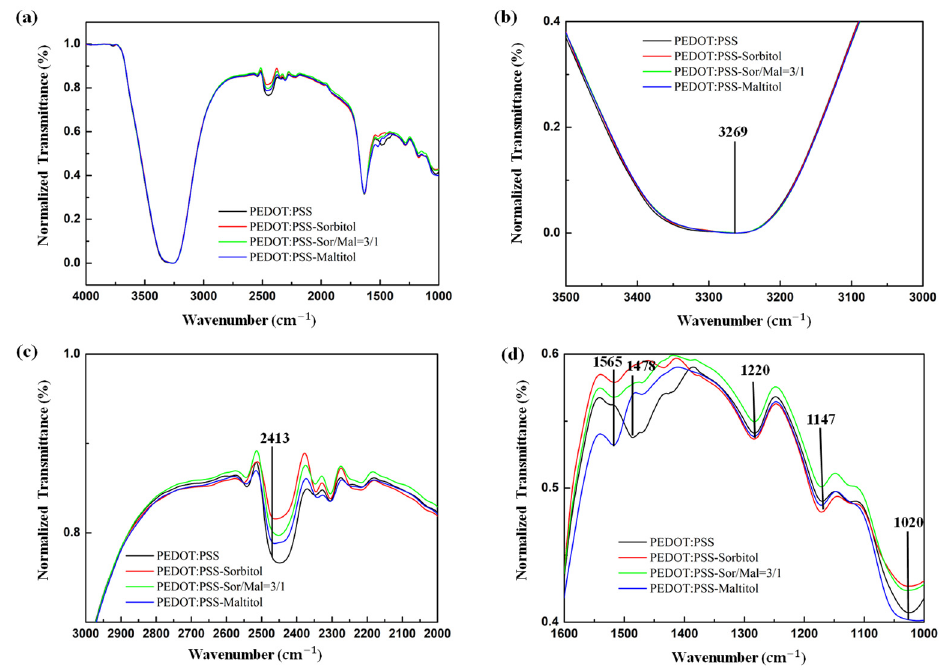
Figure 7. Normalized FTIR spectra of PEDOT: PSS without and with organic additives at ( a ) 4000~1000 cm − 1 , ( b ) 3500~3000 cm − 1 , ( c ) 3000~2000 cm − 1 , and ( d ) 1600~1000 cm − 1